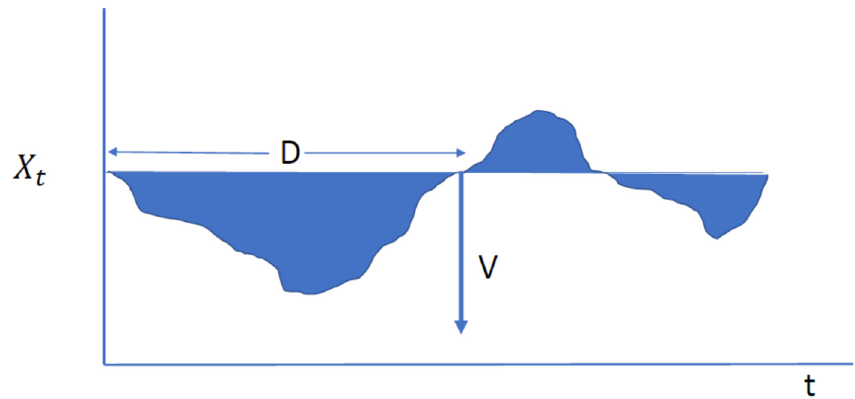
Figure 2. Schematic of crossing properties.